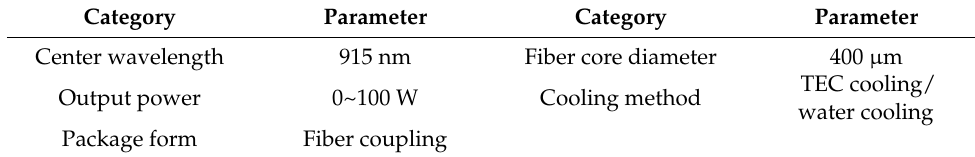
Table 2. Parameters of semiconductor